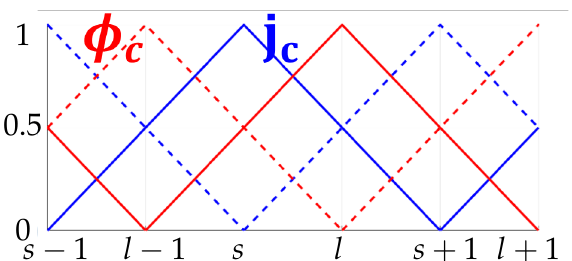
Figure 2. Primal ( T ) and dual ( ˜ T ) temporal